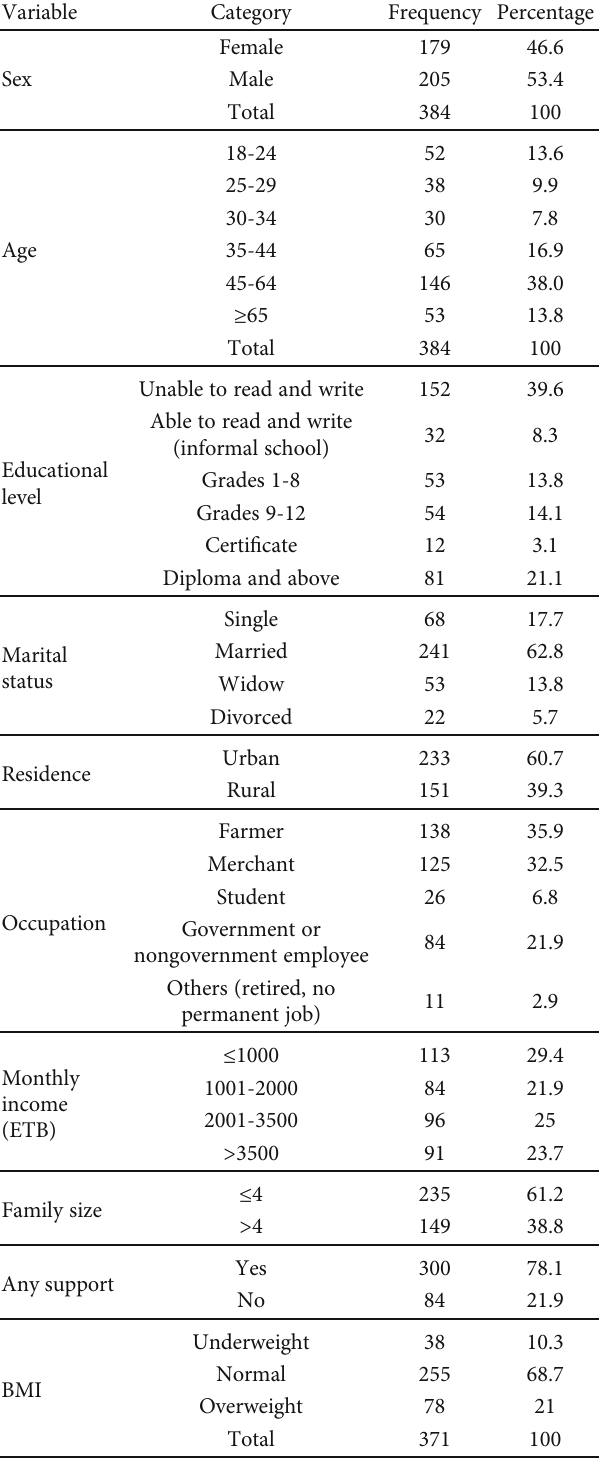
Table 2: Sociodemographic status of diabetes, hypertension, and heart failure patients at Debre Markos Referral Hospital Chronic Illness Follow-up Clinic, 2018 ( N